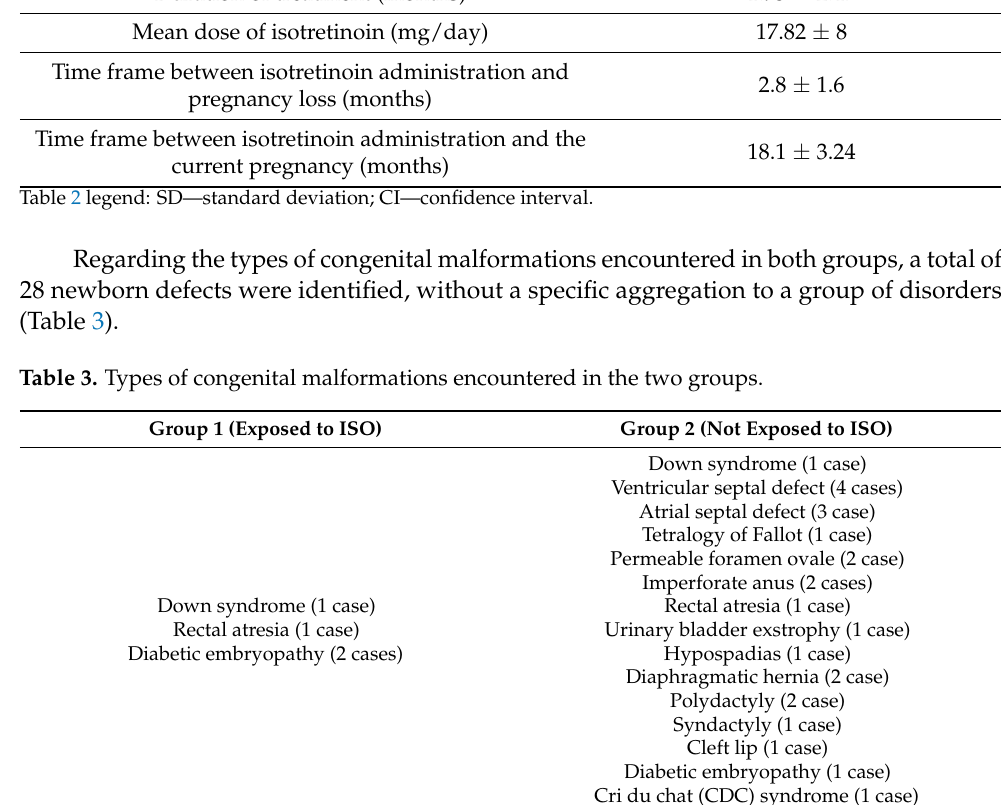
Table 3 legend: ISO—isotretinoin; CDC—cri du chat (CDC)